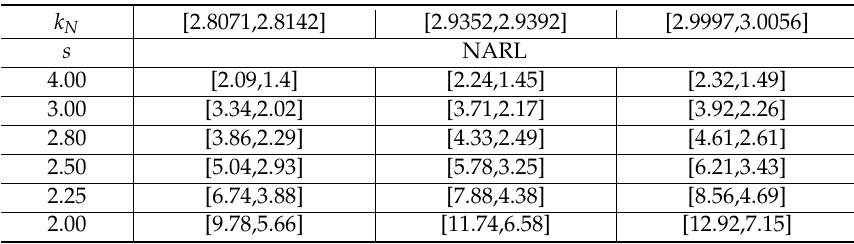
Table 3. The values of NARL when a N (cid:15) [ 0.95,1.05 ] and k N (cid:15) [ 3,5 ]